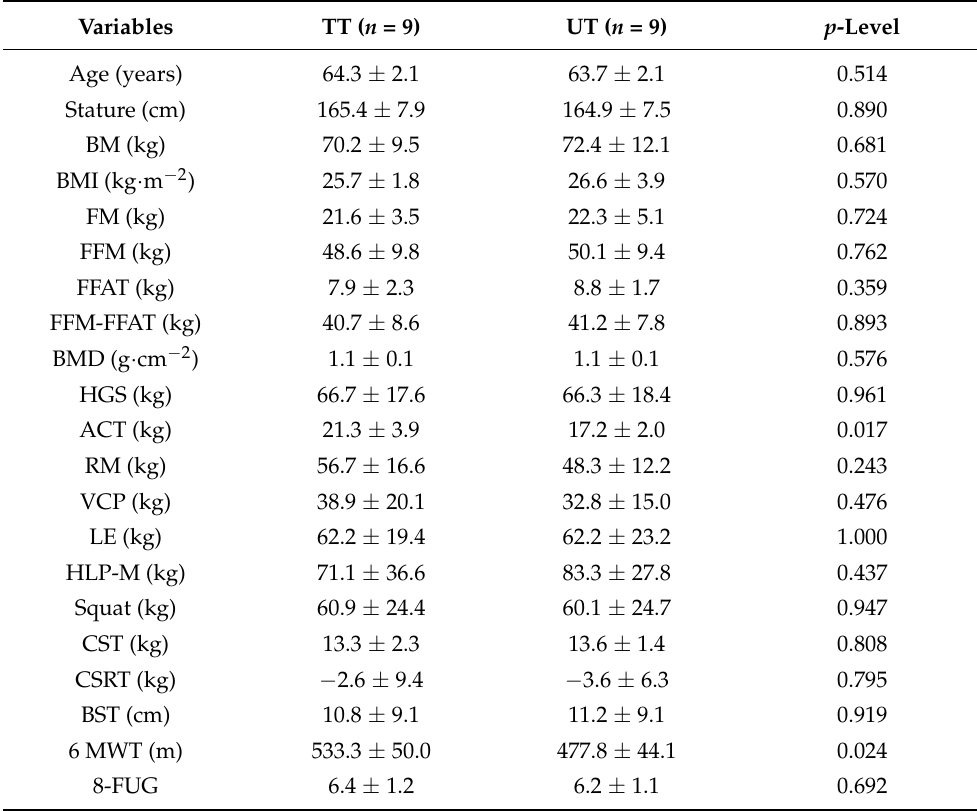
Table 1. Characteristics of the